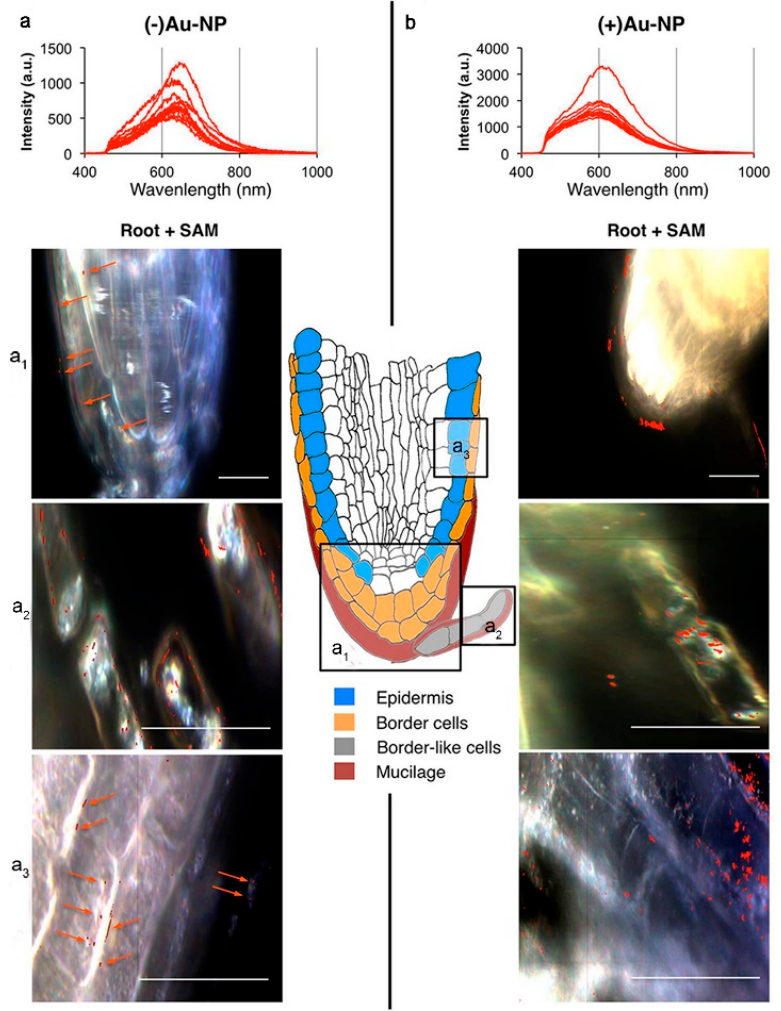
Figure 2. Spectral libraries used for the nanomaterial mapping of ( a ) ( − ) Au-NPs and ( b ) (+) Au-NPs. ( a 1 – a 3 ) Dark-field microscopy images of Arabidopsis thaliana roots exposed to 10 mg/L of ( − ) Au-NPs ( left ) and (+) Au-NPs ( right ). Red pixels: ( − /+) Au-NPs mapped using the spectral angular mapping algorithm (SAM; 0.085 rad). Images of different root compartments in the top root. ( a 1 ) Root cap with border-like cells and mucilage. ( a 2 ) Detaching border-like cells. ( a 3 ) Lateral root cap and epidermis. (The orange arrows points to where the Au-NPs are distributed.) Reprinted with permission from Ref. [29].